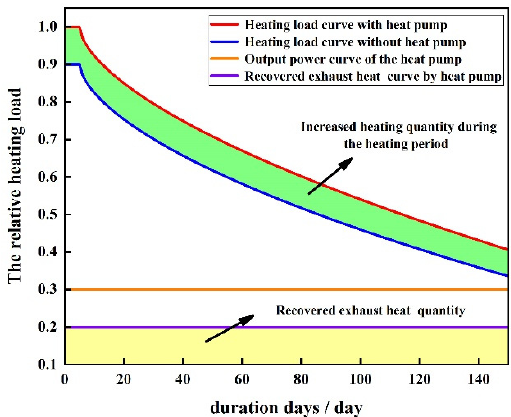
Figure 7. The heating load characteristic for the heating supply system.